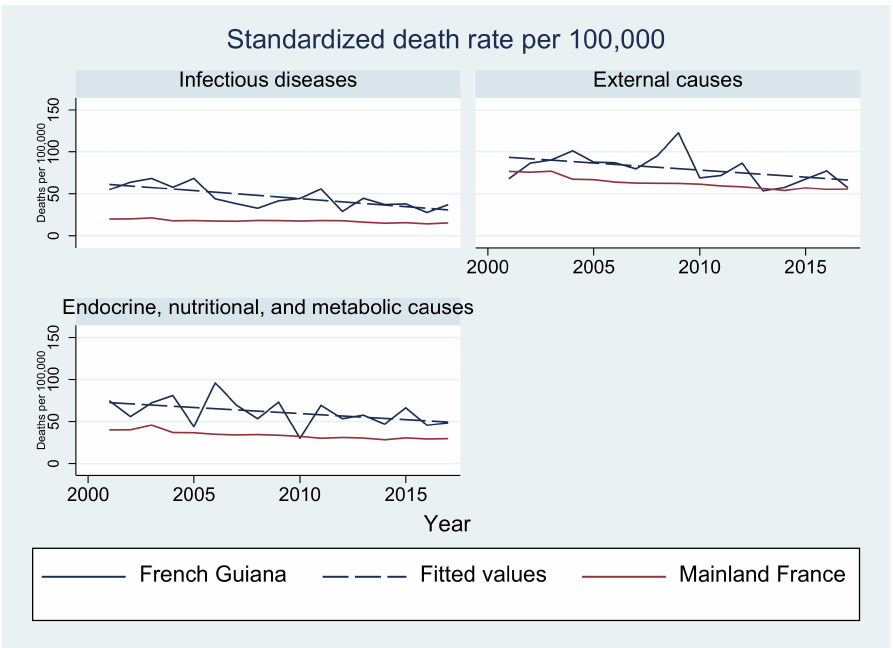
Figure 6. Evolution of the standardized death rate for infectious diseases, external causes, and endocrine, nutritional, and metabolic diseases: French Guiana vs. mainland